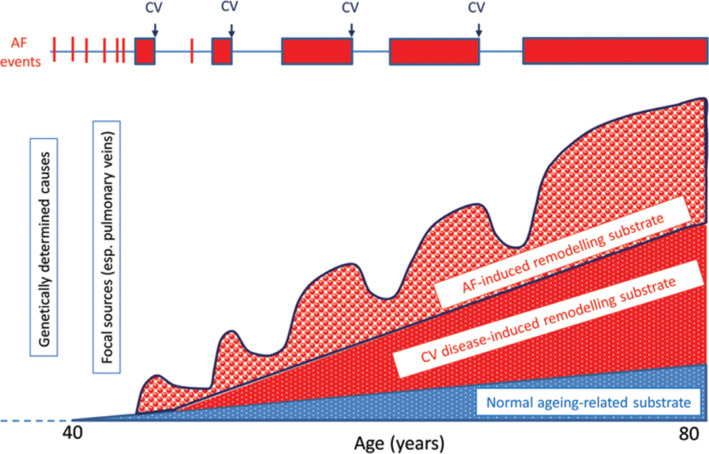
A conceptual model of AF events in relation to the underlying atrial substrate. Genetically determined causes of AF predominate prior to the age of 40 years, with focal sources and reentrant substrates being more prevalent thereafter. These substrates are induced by cardiovascular disease–induced remodelling as well as the arrhythmia episodes themselves. Arrhythmia control as well as therapies directed at modifiable cardiovascular risk factors may reverse electrical and structural remodelling. Reproduced with permission from: Nattel S, Guasch E, Savelieva I, et al. Early management of atrial fibrillation to prevent cardiovascular complications. Eur Heart J. 2014;35(22):1448–1456.